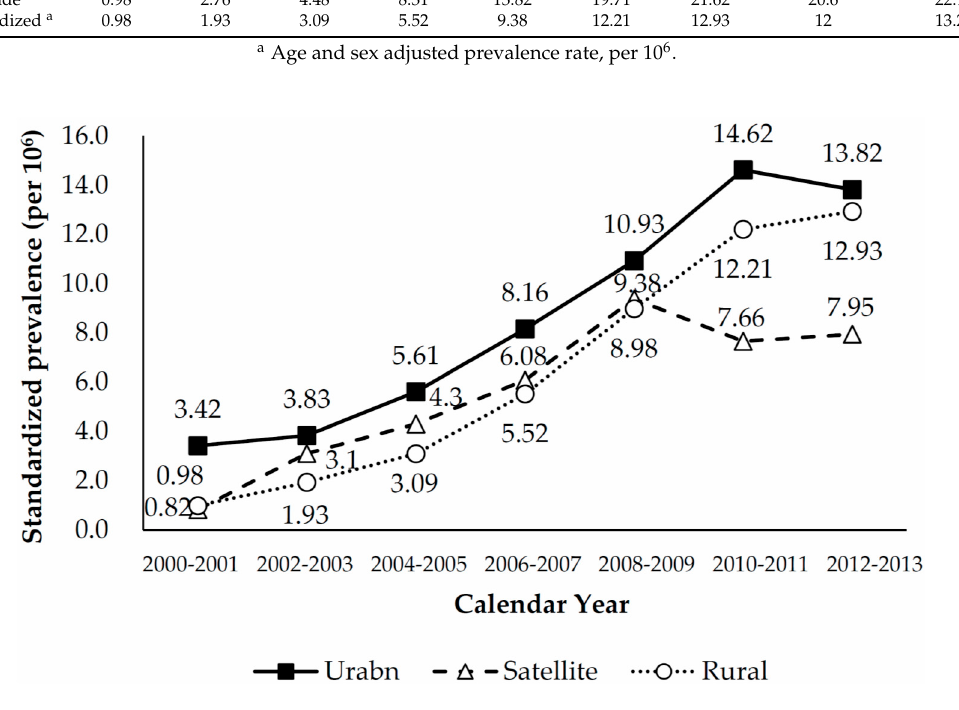
Figure 3. Sex ‐ age ‐ standardized biennial prevalence of liver transplantation in Taiwan, 2000–2013, according to level of urbanization.